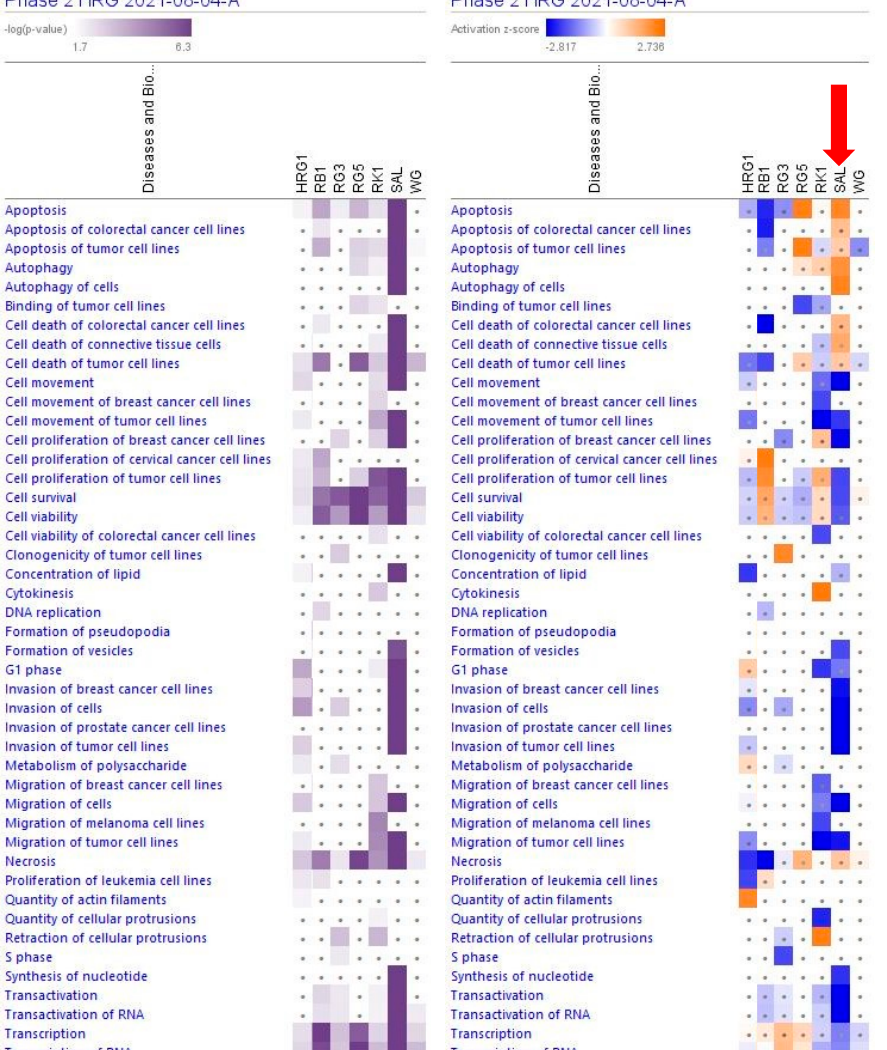
Figure 4. Predicted effects of RG–RS (SAL) at a concentration of 20 µ g/mL, RG at a concentration of 10 µ g/mL (HRG1), white ginseng (WG), and ginsenosides Rb1, Rg3, Rg5, Rk1 at a concentration of 0.1 µ M on cellular and physiological functions. The violet color shows the p -value (calculated using a Right-Tailed Fisher’s Exact Test), indicating the statistical significance of the overlap of analyzed dataset genes within the functions; the intensity of color corresponds to the log p -value in a scale from 1.7 to 6.3 (upper panel). The function scores are shown using a gradient from dark blue to brown for predicted activation and light to dark blue for predicted inhibition of diseases; the intensity of color corresponds to the activation zone on a scale from − 2.817 to +2.736 (upper panel). symbol · shows that the activation z-score was < 2 and the − log p -value <1.3 = p < 0.05. An absolute z-score ≥ 2 is considered significant activation (+) or inhibition (-). The activation z-score predicts the activation state of the function using the gene expression